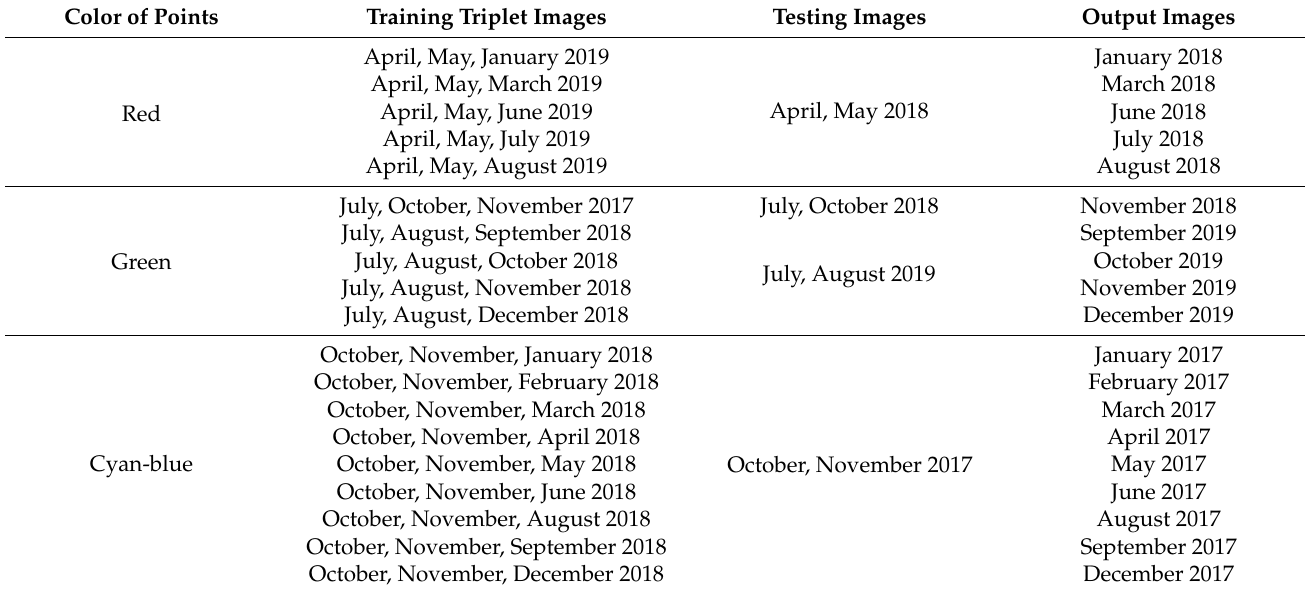
Table 2. Training triplet images, testing images, and output images in third set of experiment. Color of